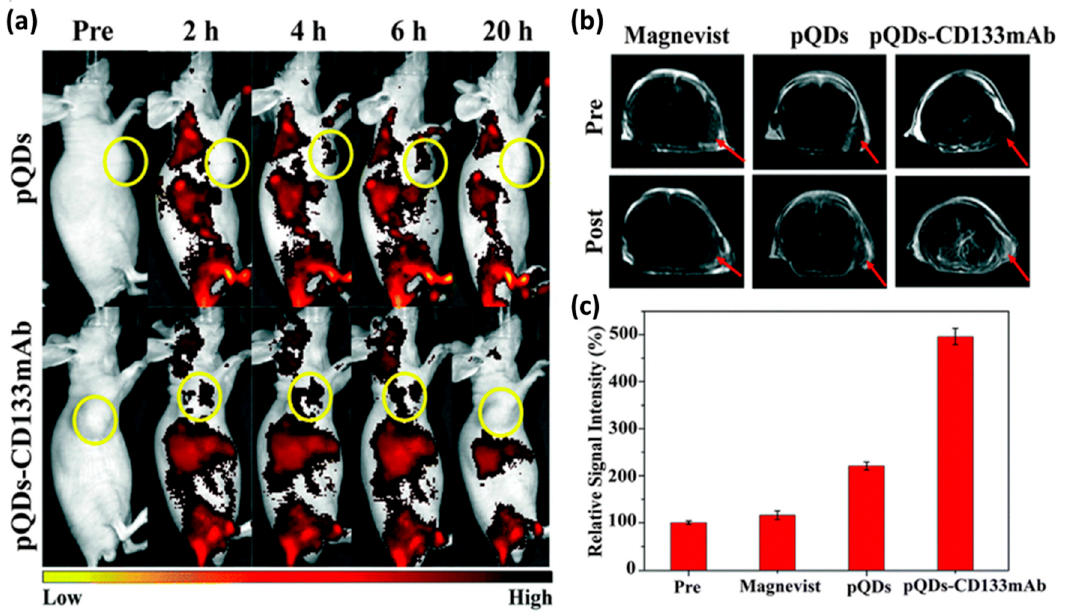
Figure 18. ( a ) In vivo fluorescence images of nude mice-bearing CD133+ glioma tumors indicated by the yellow circles before and after intravenous injection with hydrophilic paramagnetic QDs (pQDs) and CD133mAb-pQDs. The excited wavelength was 470 nm. ( b ) In vivo T1-weighted magnetic resonance (MR) images of nude mice-bearing CD133+ glioma tumors before and after injection of pQDs-CD133mAb, pQDs and Magnevist (4 h). ( c ) Relative T1 enhancement values of the glioma areas before and after injection of Magnevist, pQDs and pQDs-CD133mAb, respectively [116]. Chemosensors 2020 , 8 , x FOR PEER REVIEW